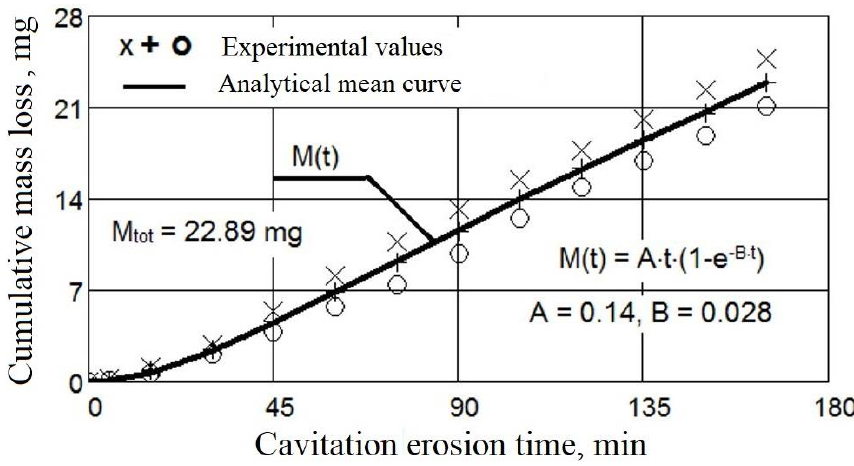
Figure 6. Mass losses of GX40CrNiSi25-20 steel related to the cavitation time (no remelting).